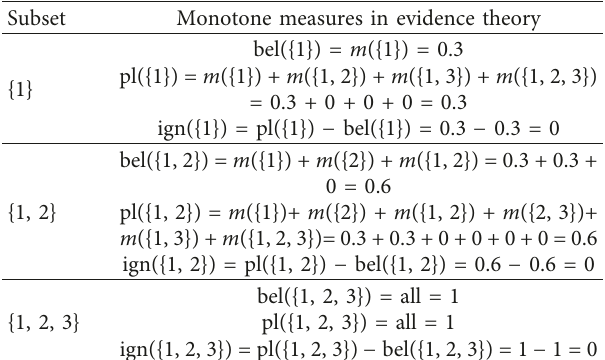
Table 12, certainty and possibility measures in possibility theory are calculated using equations (11) and (12) as pre- sented in Table 13. As expected, the belief and plausibility measures in Table 11 are equal to the certainty and possi- bility measures in Table 13 respectively.